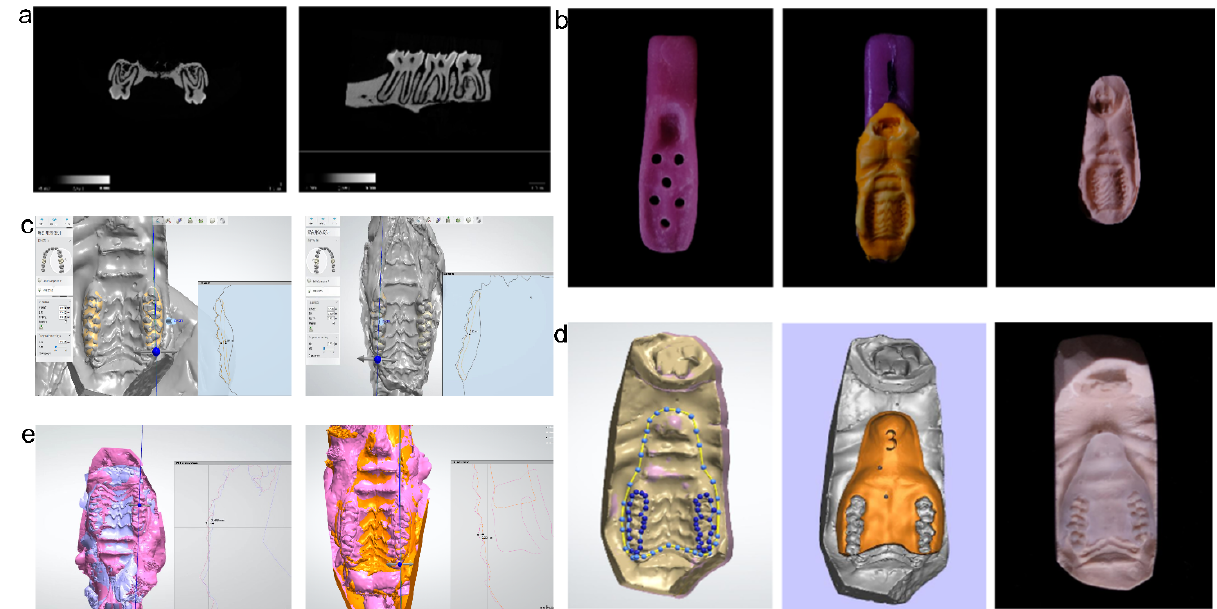
Figure 1. Schematic diagram of experimental occlusal disharmony. ( a ) Three-dimensional recon- structed microtomography images of maxilla, coronal and sagittal sections. ( b ) Individual trays for rats made with lightly-cured resin materials (left), impression of maxillary dentitions (middle) and the cast model (right). ( c ) Virtually prepared teeth in the software. ( d ) Designed and 3D-printed TRS guide. ( e ) Prepared teeth model that was scanned to compare with the original model to assess accuracy.